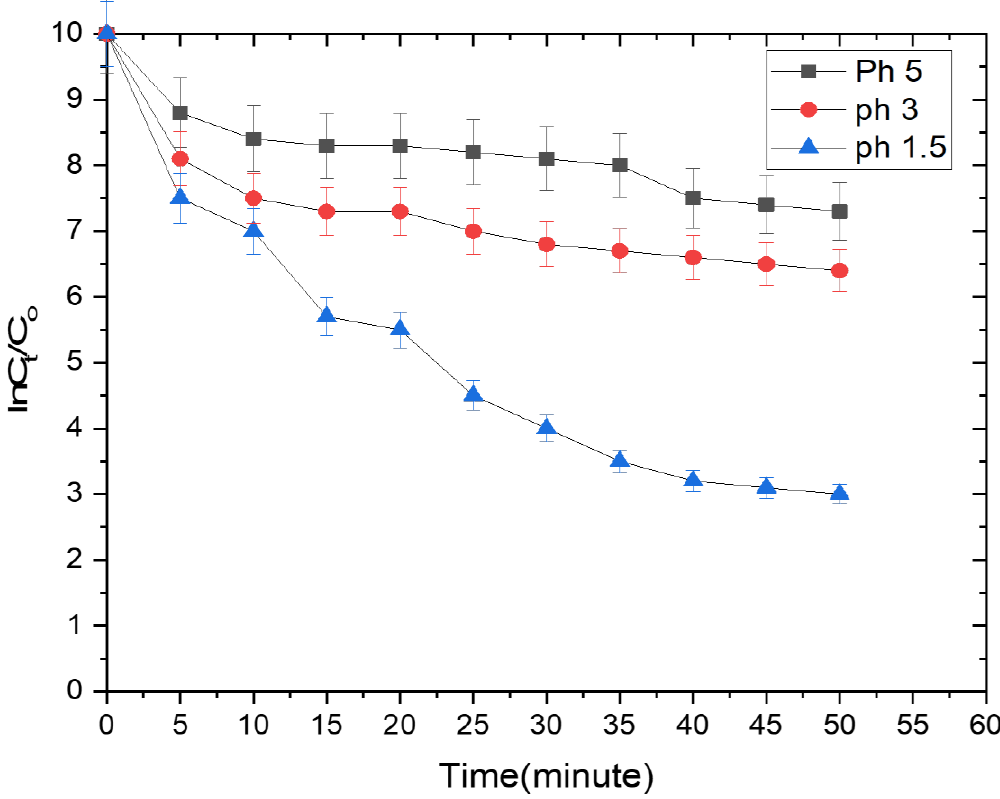
Figure 10. Comparison graph of photocatalytic reduction of Cr (VI) to Cr (III) at different pH values.